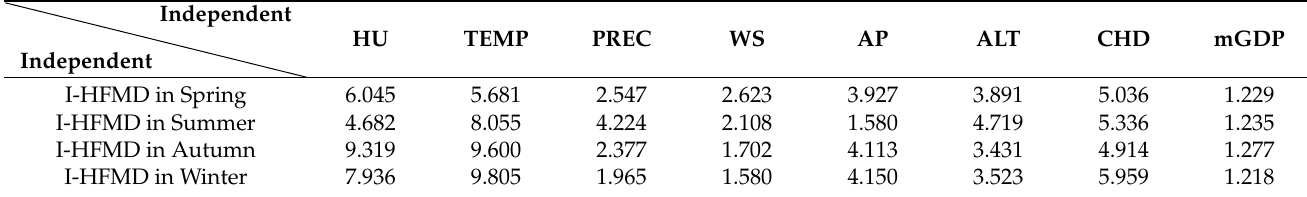
Table 4. VIF values of multicollinearity testing of potential risks for each